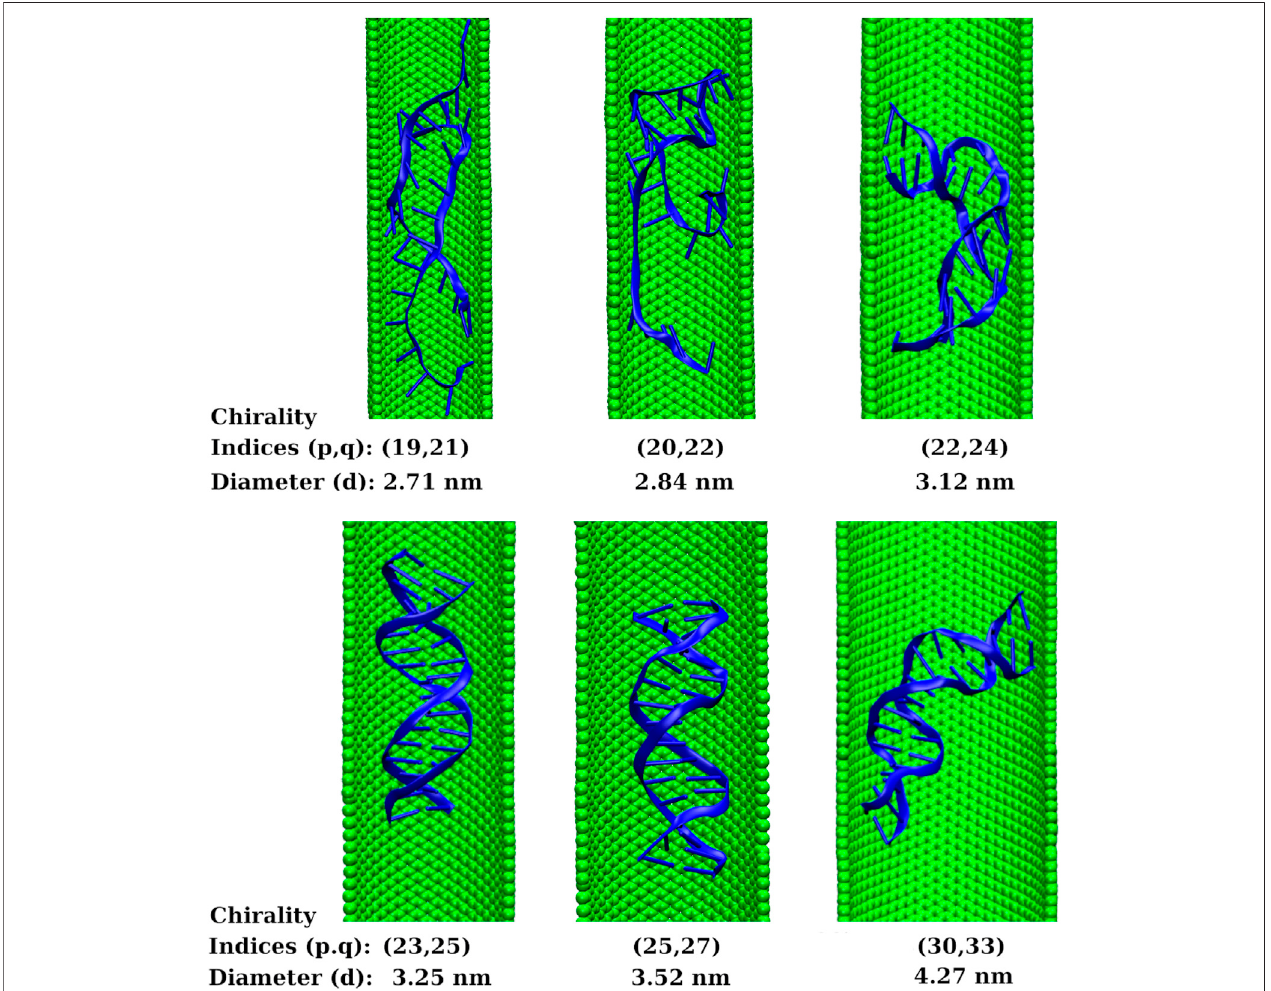
FIGURE 9 | Instantaneous snapshots of dsDNA inside chiral SWCNTs of chirality indices (19,21), (20,22), (22,24), (23,25), (25,27), and (30,33) that correspond to diameters 2.71, 2.84, 3.12, 3.25, 3.52, and 4.27 nm, respectively. The snapshots depict that the threshold diameter of chiral SWCNT is also 3.25 nm for the proper con fi nement of the dsDNA inside the SWCNT.